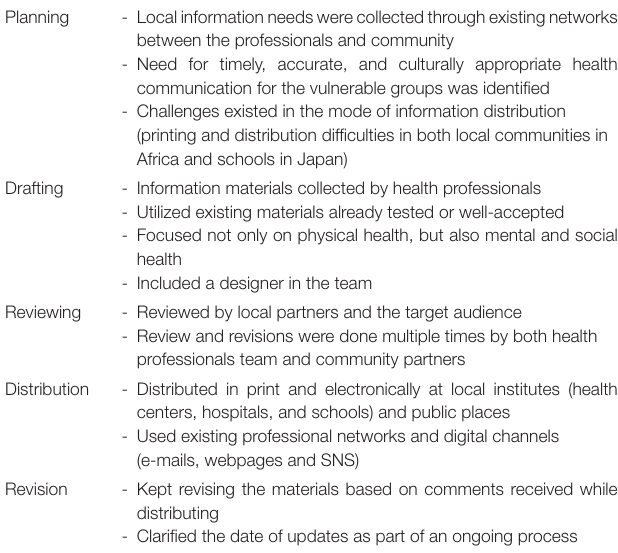
TABLE 2 | Common development processes in two countries: from conceptualization to dissemination.